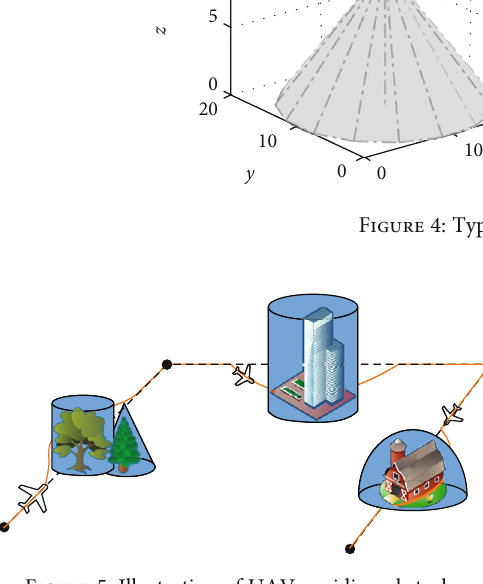
Circular table (p = q = r = 1; r<1; a = b)